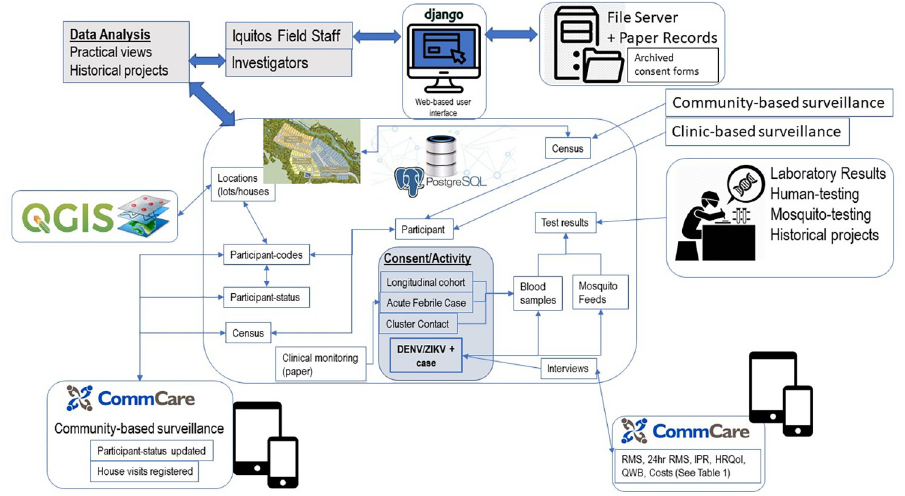
Fig 4. Data structure and integration for the project. All data was managed in PostgreSQL relational database with a direct link to a geographic information system in Quantum GIS. Additional data was captured through mobile android applications using CommCare software and later processed and imported into